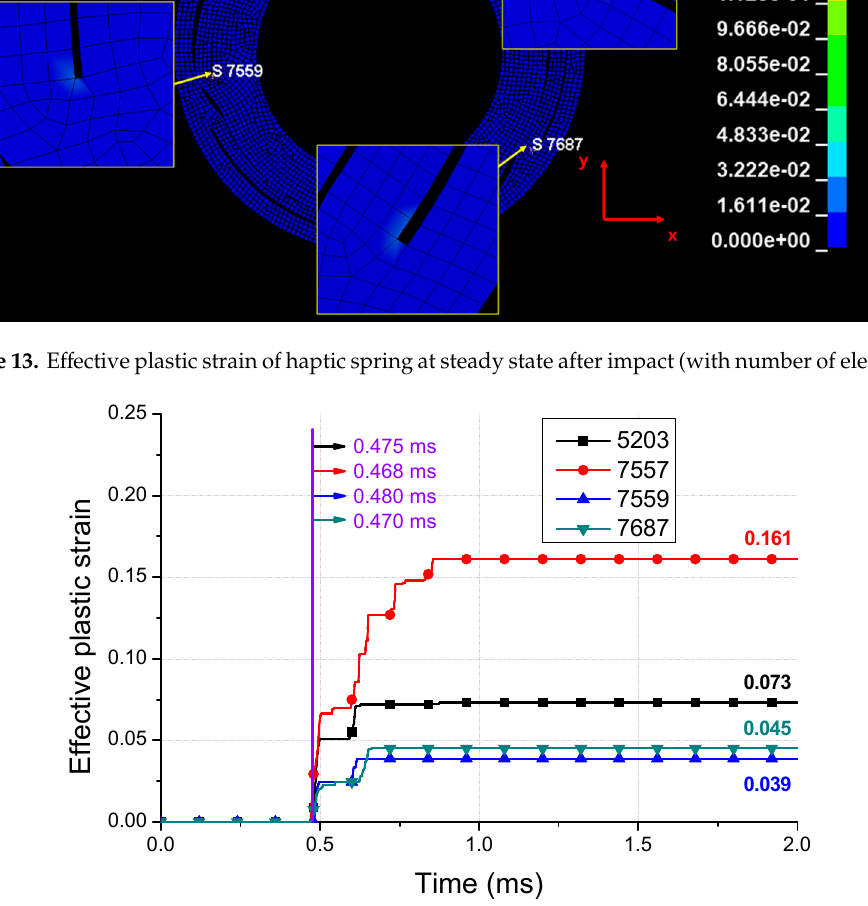
Figure 14. Effective plastic strain of the damage area (with the number of elements shown in Figure